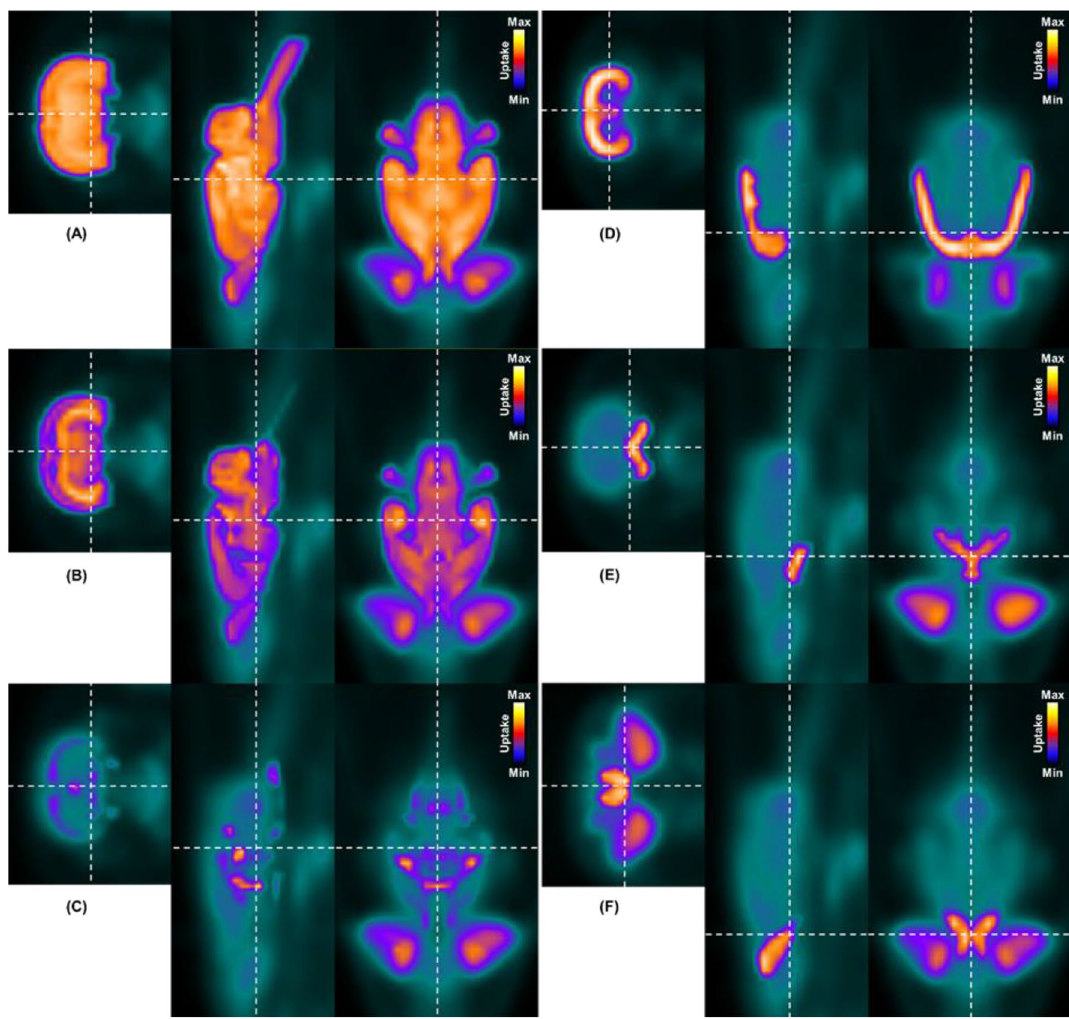
Figure 1. Co-registered PET image template based on the sham-operated controls as well as following anatomical image information: MRI T2* image ( A ), gray matter ( B ), white matter ( C ), the neocortex ( D ), the basal forebrain region ( E ) as well as the olfactory system ( F